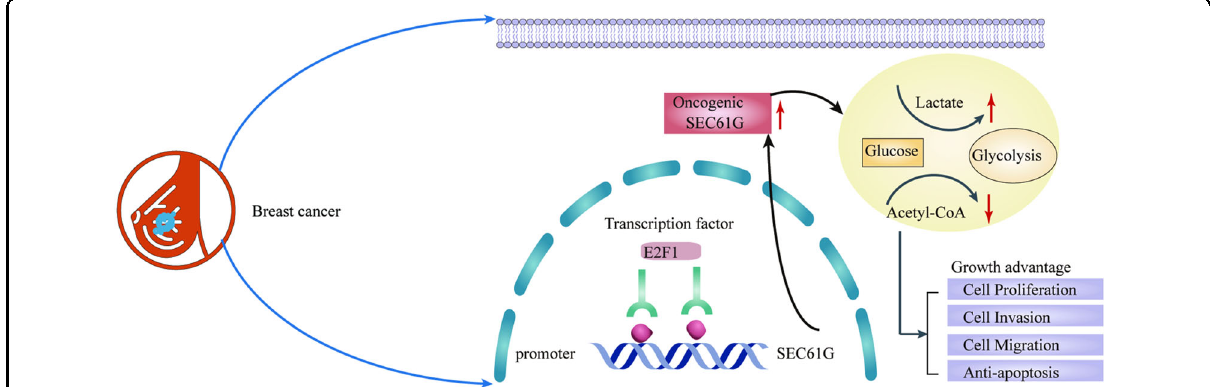
Fig. 8 Schematic representation depicting the mechanisms that E2F1/SEC61G axis affects the progression of breast cancer. The diagram elucidates the functional axis of E2F1/SEC61G in regulating glycolysis and cell growth in breast